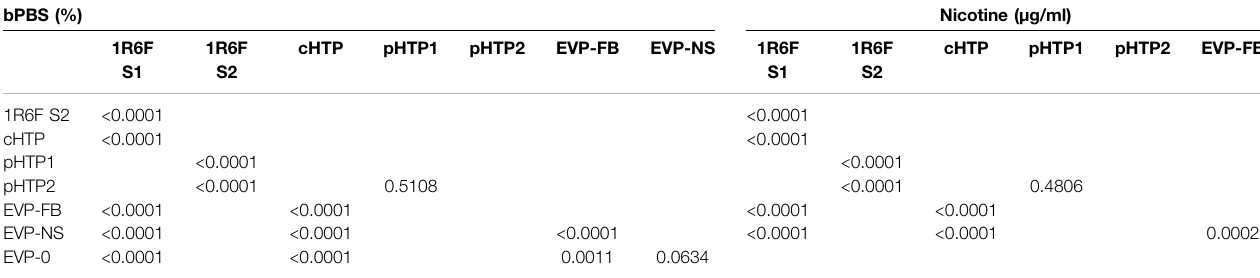
TABLE 7 | Prediction model of the F test comparison ( p values) for the product dose response curves, relative to %bPBS or nicotine ( μ g/mL). bPBS (%)